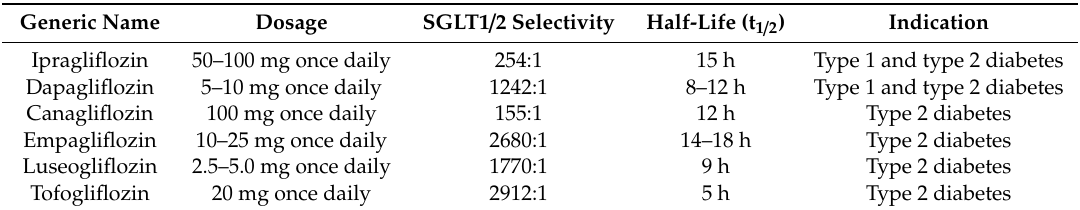
Table 1. Sodium-glucose cotransporter 2 (SGLT2) inhibitors available in